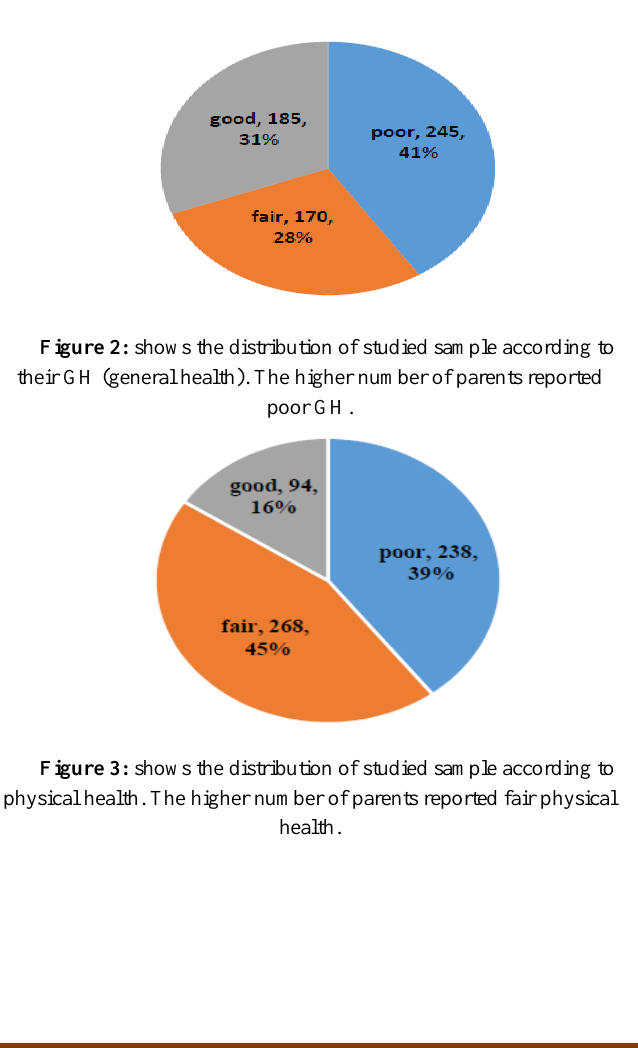
Figure 1: shows the distribution of studied sample according to their general QoL. The higher number of parents reported fair general QoL.